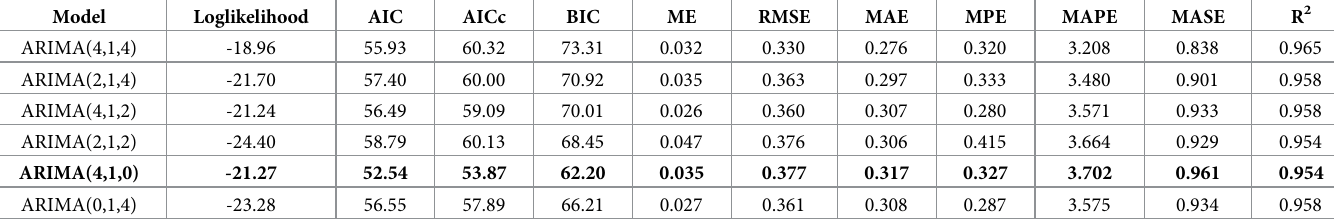
Table 3. AIC, BIC and AICc values for suggested ARIMA models for sucide rate in India.